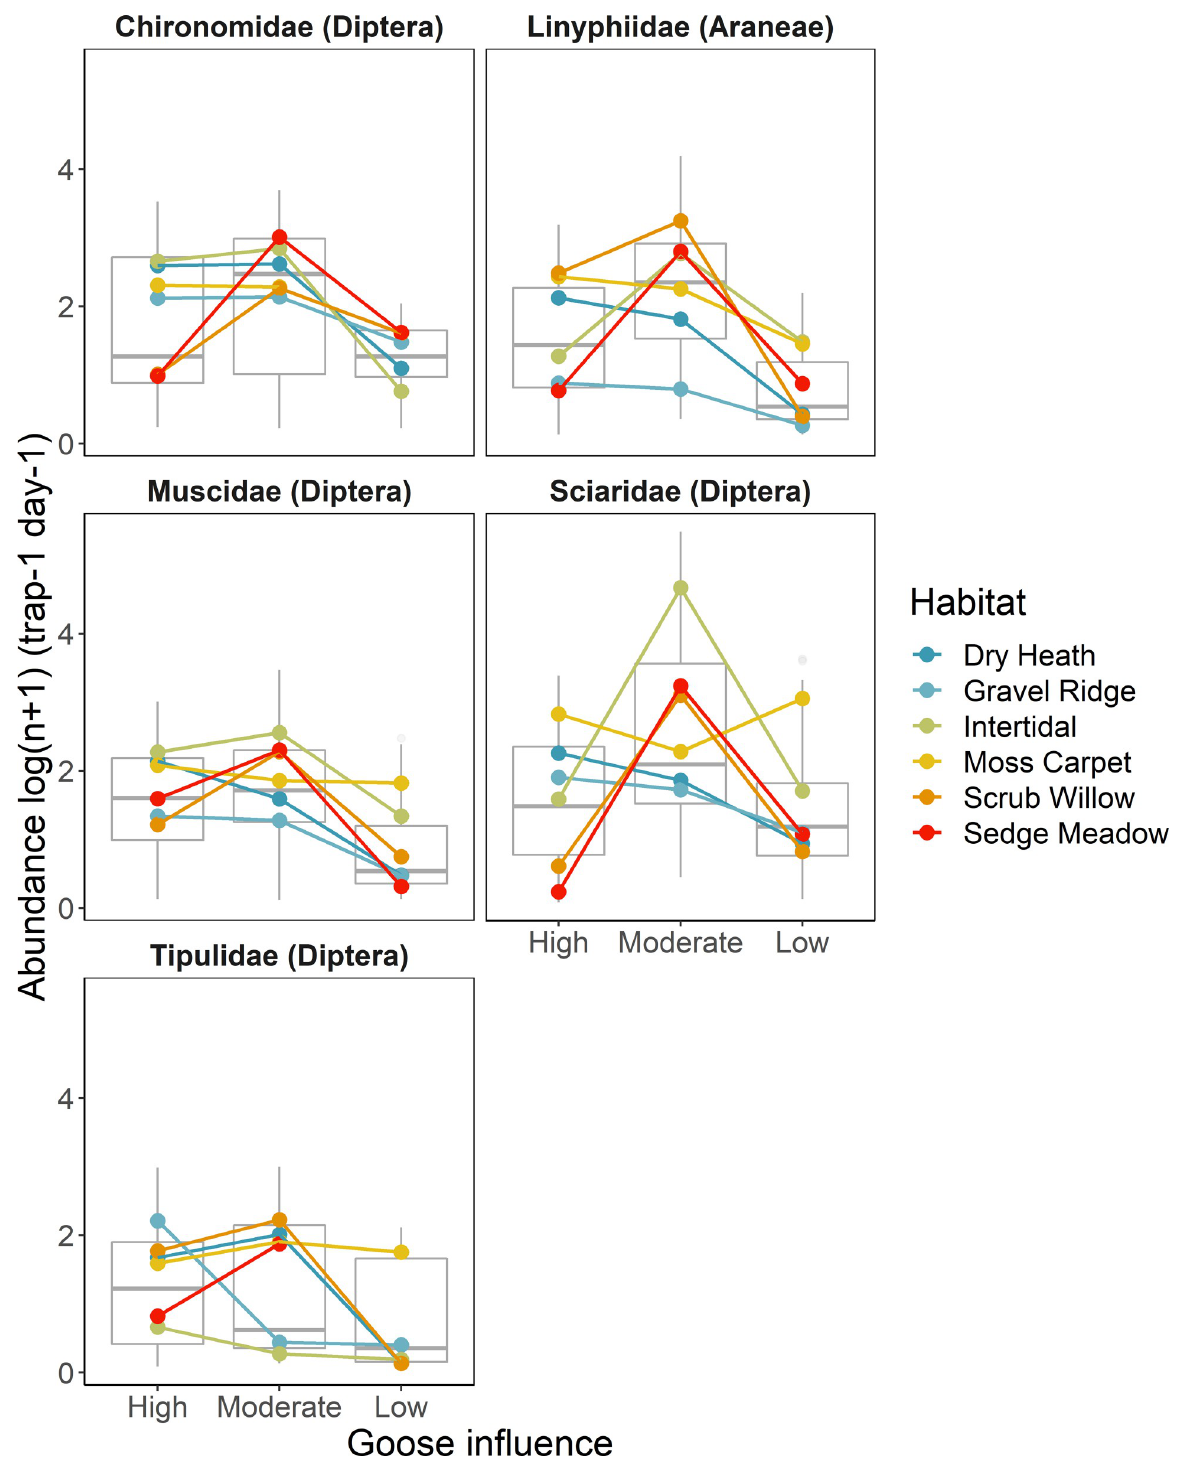
Fig 2. Abundance (per trap per day, log transformed) for the five most abundant invertebrate families collected using pitfall traps in six dominant habitat types at three sites representing a gradient of goose influence.